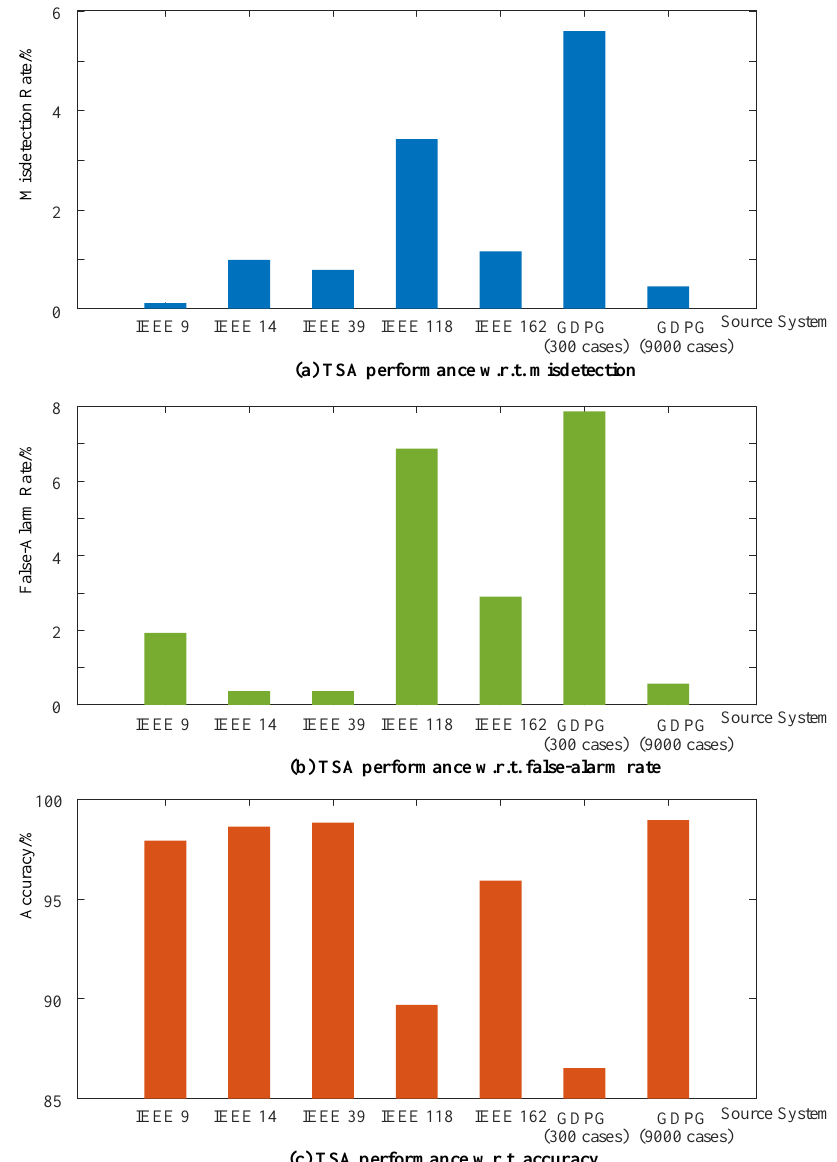
Figure 5. TL-based Online TSA Performances on